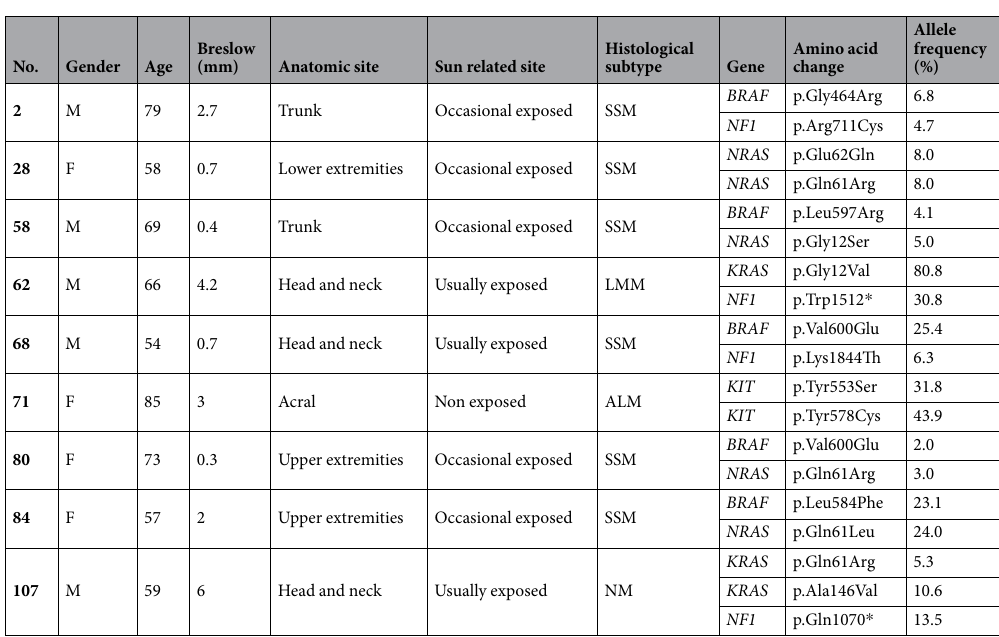
Table 3. Clinicopathological characteristics of the samples with concurrent mutations in the four genomic subtypes. M: Male; F: Female; SSM: Superficial spreading melanoma; LM: Lentigo Maligna; NM: Nodular melanoma; ALM: Acral lentiginous